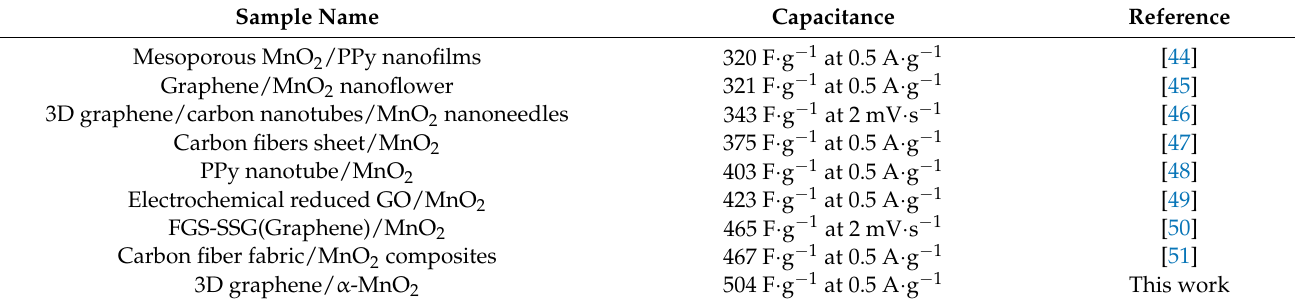
Table 1. The capacitance of MnO 2 –carbon